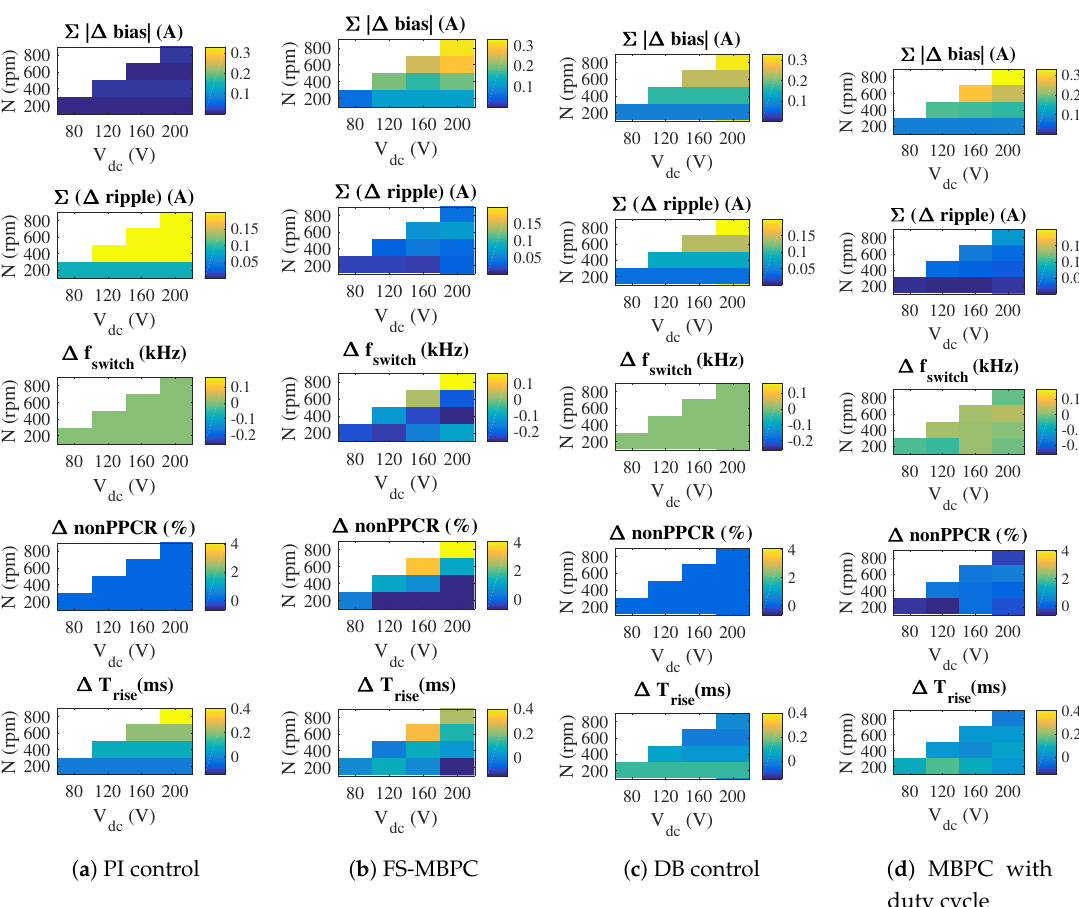
Figure 19. Effect of DC-bus voltage V dc and mechanical speed N on the difference between the KPIs for a faulty and a healthy